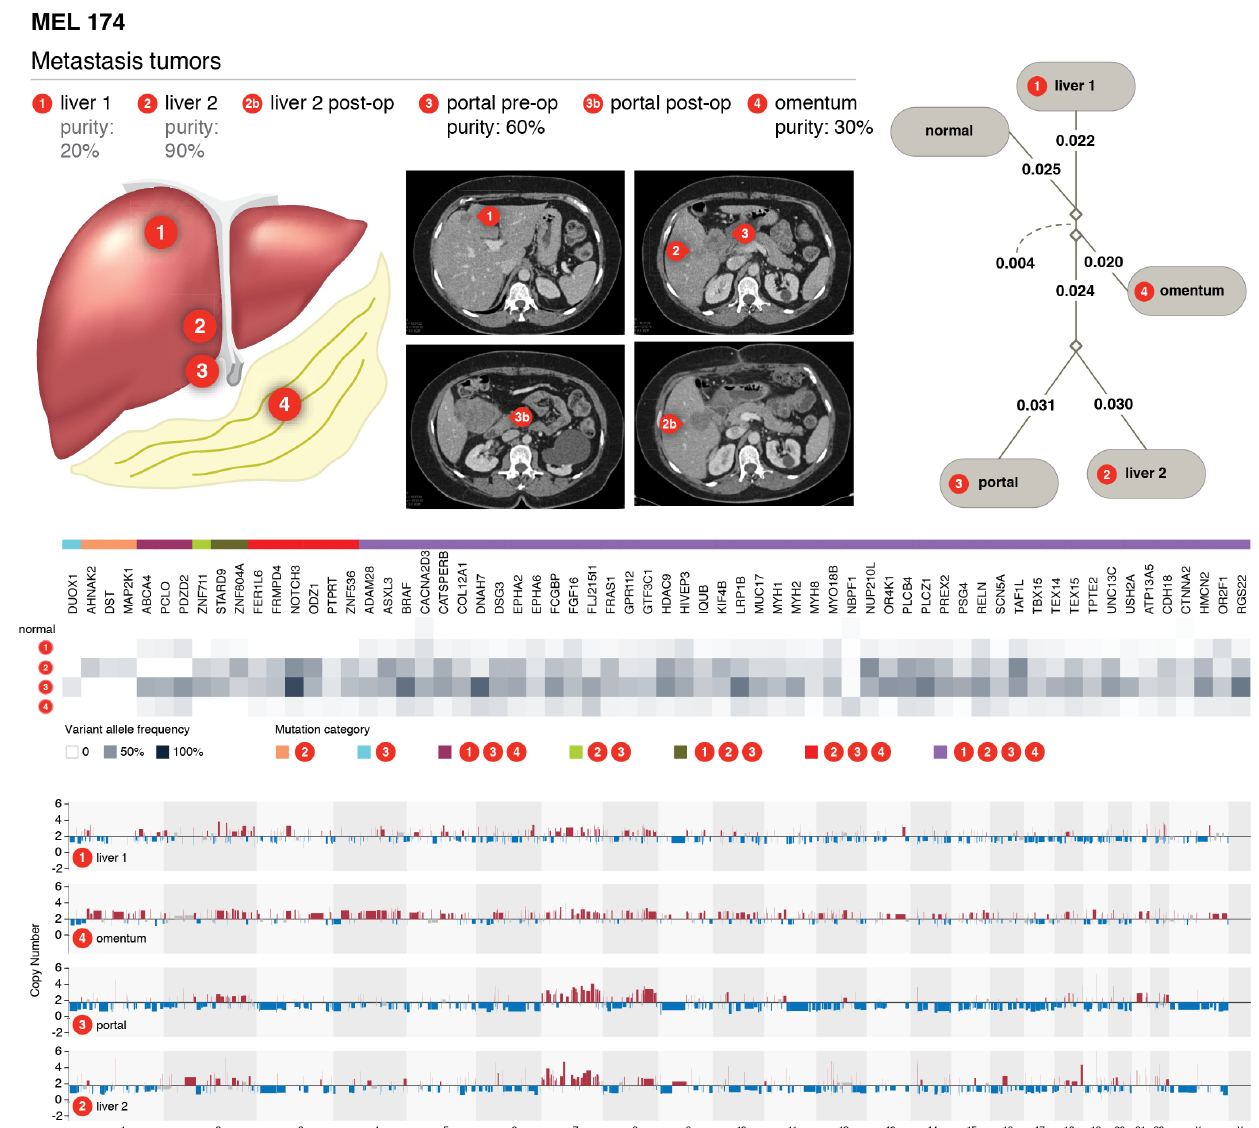
Figure 8. Phylogenetic and mutational relationships among four metastatic samples from different sites of the same individuals (MEL 174). Geographic locations and CT scans of metastasis samples in MEL 174 with 2 samples from liver (liver tumor 1, liver tumor 2), one from omentum, and one from portal nodule. Phylogenetic relationships among 4 metastatic tumors were shown. Purity based VAF corrections were applied prior to phylogenetic analysis. Increased variant allele frequency of BRAF (V600E) in liver 2 and portal module, both tumors showed resistance to vemurafinib treatment. BRAF amplifications were also shown in liver 2 and portal module tumors.